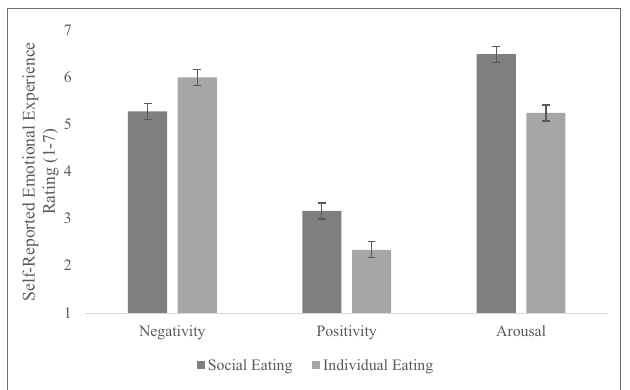
FIGURE 1 | Self-reported emotional experience as a function of type of social eating cues present in the obesity PSA messages.